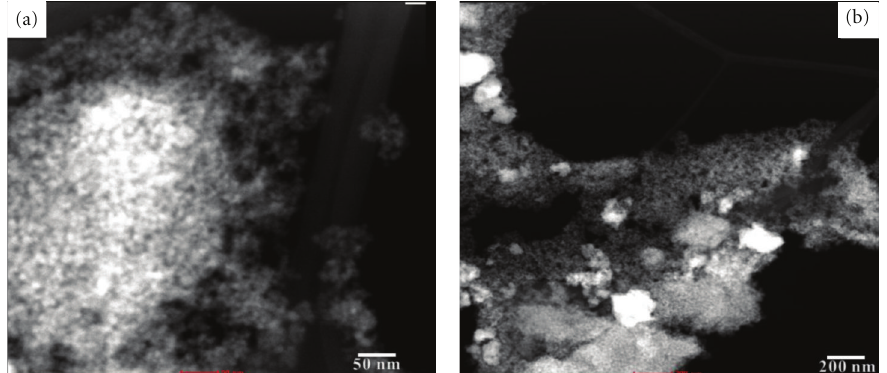
Figure 6: TEM image of sample T10Z-400 obtained by Z-contrast technique, (a) macro-mesoporous “sponge-” like agglomerate, (b) di ff erent agglomerates, with mesoporous